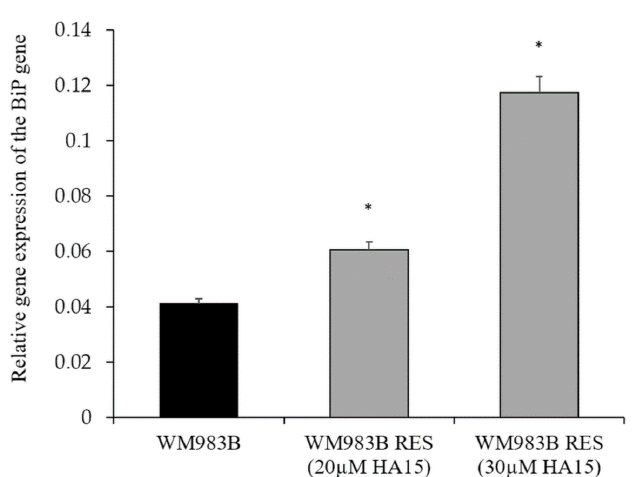
Figure 11. BiP gene expression of the WM983B HA15 -resistant cell line. Two HA15-resistant cell lines were developed by long-term HA15 treatment. The resistant cell lines (grey columns) showed increased BiP gene expression compared to the parental cells (black column). Data are presented as the mean ± SD of three independent experiments. Asterisks indicate significant differences ( p ≤